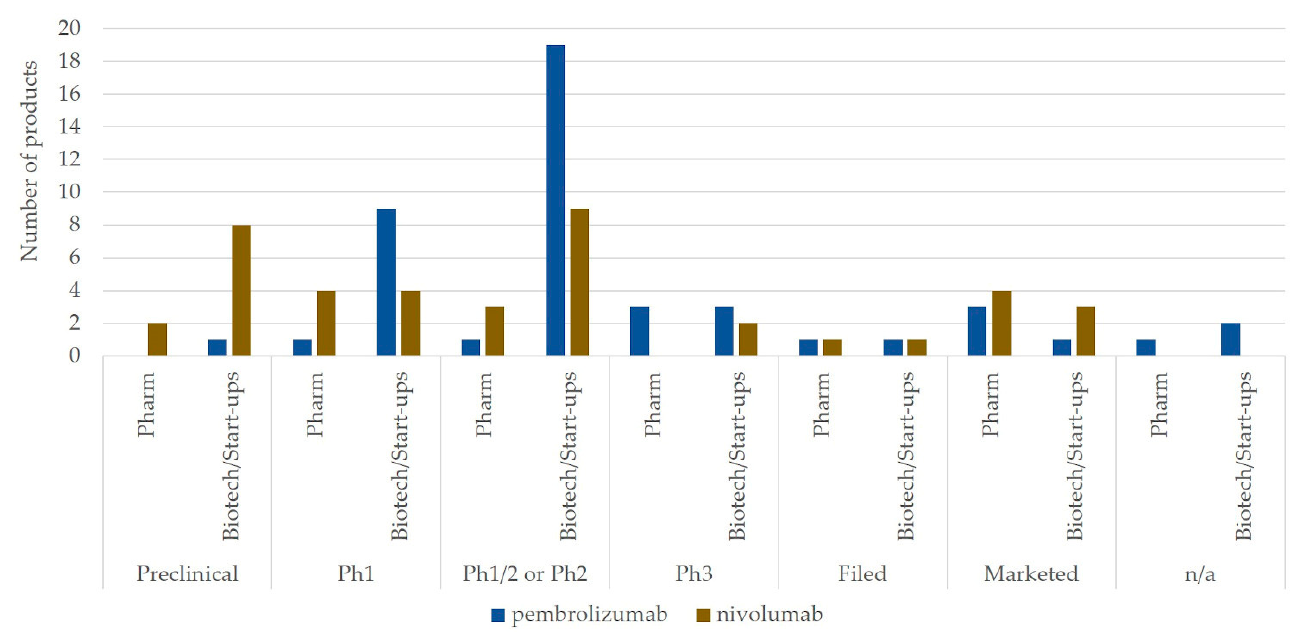
Figure 3. Number of products that were tested with pembrolizumab or nivolumab for combination therapy development. The number of products is displayed by the type of developing company as Pharm or Biotech/Start-ups. Pharm: phar- maceutical company, Biotech: biotechnology company, Start-ups: start-up company, Ph1: Phase 1, Ph1/2 or Ph2: phase 1/2 or phase 2, Ph3: phase 3, Filed: initial regulatory filing, Marketed: marketed after the initial regulatory approval, n/a: not